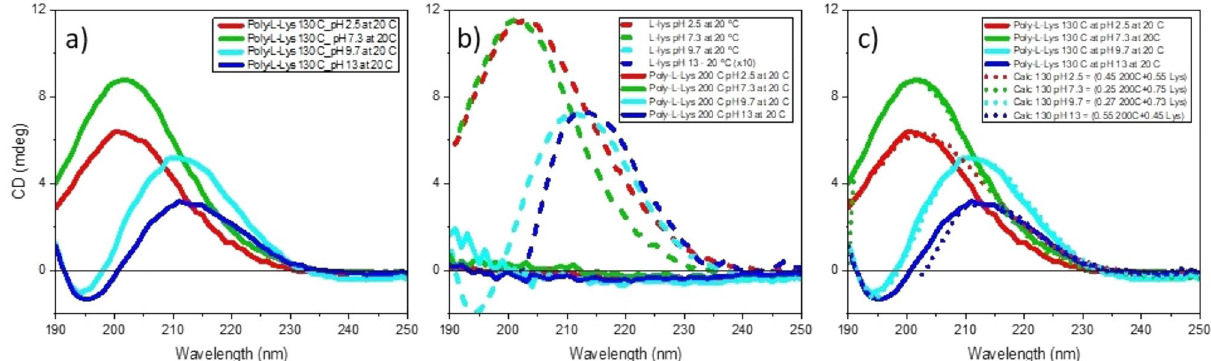
Figure 9. ( a ) CD spectra of HT-130 °C poly-l-lysine prepared from l-lysine aqueous solutions at different pHs (2.5, green line; 7.3, sky blue line; 9.7, red line; blue, 13). The samples have been measured at 20 °C. ( b ) CD spectra of HT-200 °C poly-l-lysine prepared from l-lysine aqueous solutions at different pHs (2.5, green line; 7.3, sky blue line; 9.7, red line; blue, 13). The samples have been measured at 20 °C. The CD spectra of pure l-lysine in aqueous solutions at different pH are the dashed lines. ( c ) CD spectra of HT-130 °C poly-l-lysine from the figure a, overlapped to the simulated CD spectra shown as dotted lines. The simulations have been performed by adding different fractions of HT-200 °C PLL (see Fig. 10b) to the corresponding l-lysine aqueous solutions. The CD spectra of l-lysine at pH 13 is normalised because it has been measured with 0.1 cm path length instead of 0.01 cm employed in the other measures.